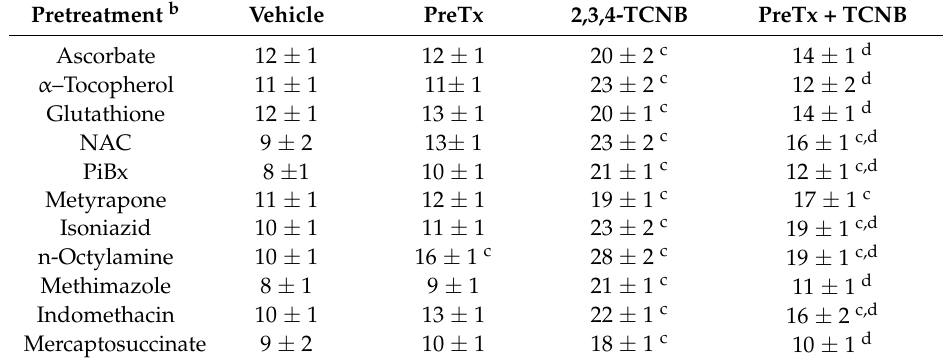
Table 1. Effect of antioxidants and metabolism inhibitors on 2,3,4-trichloronitrobenzene (2,3,4-TCNB) cytotoxicity a .